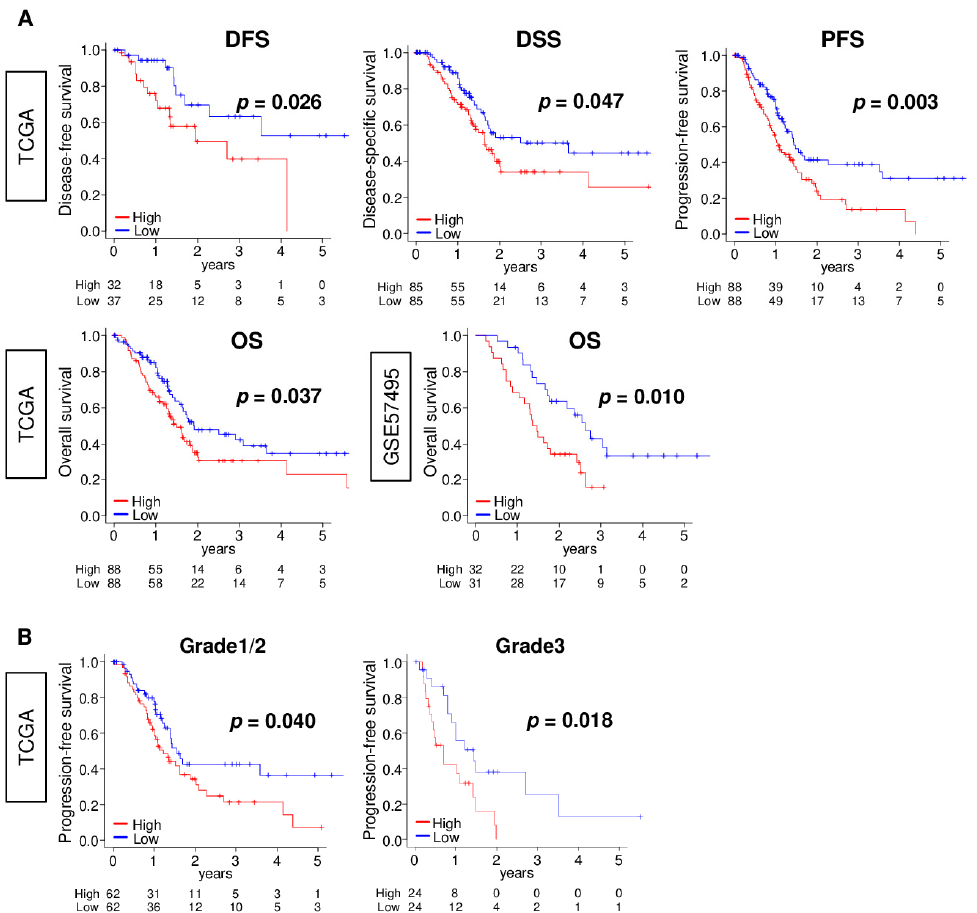
Figure 6. Association of the ANXA1 expression with patient survival in the TCGA and GSE57495 cohorts. ( A ) Kaplan–Meier curve between low (blue line) and high (red line) with disease-free survival (DFS), disease-specific survival (DSS), progression-free survival (PFS), and overall survival (OS). The median cut-off within each cohort was used to divide them into the ANXA1 low and ANXA1 high groups ( n = 88, respectively, in the TCGA and n = 31 and 32, respectively, in the GSE57495 cohort). ( B ) Kaplan–Meier curve between low and high with PFS in the pathological grades 1/2 ( n = 62, respectively) and grade 3 groups ( n = 24, respectively) in the TCGA cohort. p -values were calculated by log-rank test.